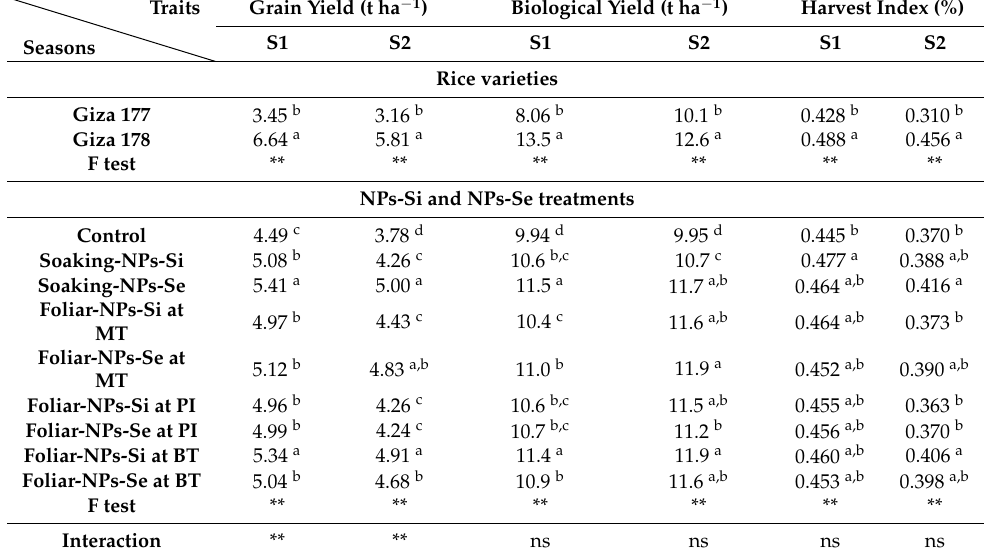
Table 9. Effect of NPs-Si and NPs-Se treatments on grain and biological yields, and harvest index of two rice varieties in saline soil during the 2018 (S1) and 2019 (S2)